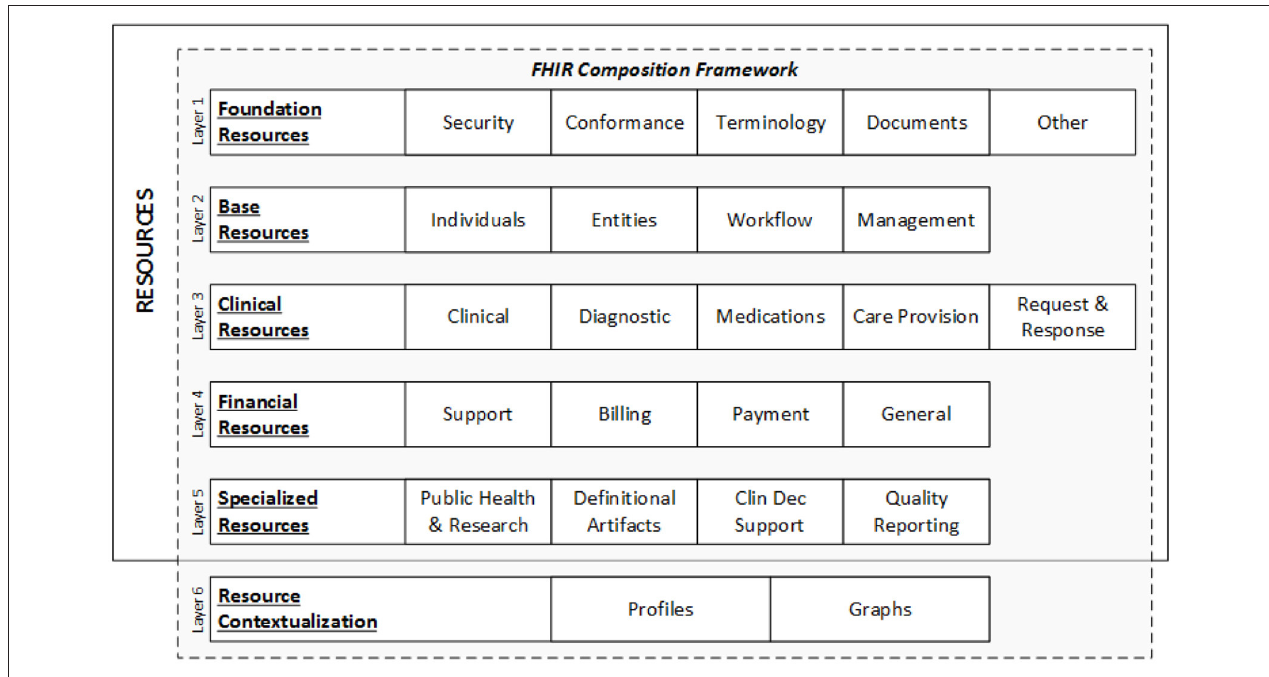
FIGURE 2 | FHIR data layers and resources (35).